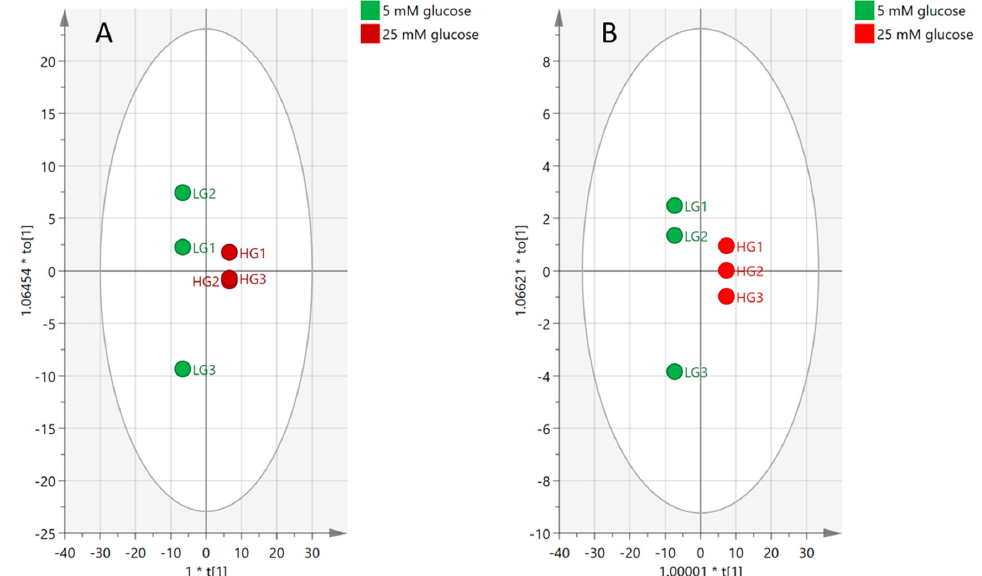
Figure 8. OPLS-DA score plots showing the effect of high-glucose media compared to normal glucose media on the pulmonary artery smooth muscle cells. ( A ) Based on 549 features. ( B ) Based on 80 significant markers affected by hyperglycemic media.